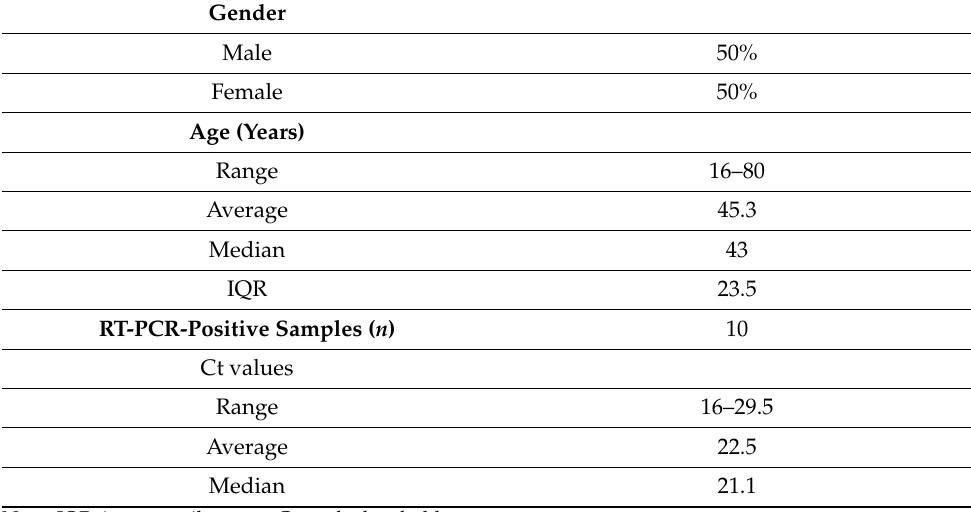
Table 3. Demographic characteristics and RT-PCR results of the included patients ( n = 60).